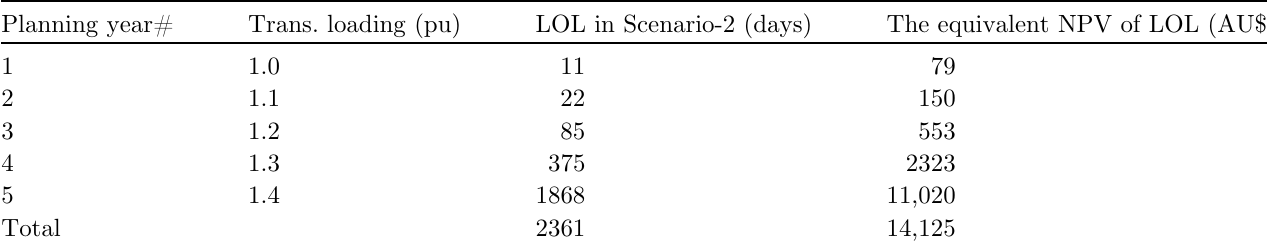
Table 3. LOL of the considered distribution transformer and the corresponding equivalent cost in Scenario-2 at all years of planning.